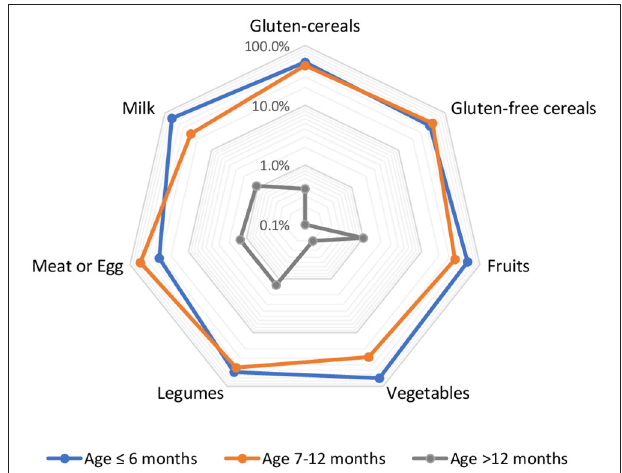
FIGURE 1 | First introduction to complementary foods by age